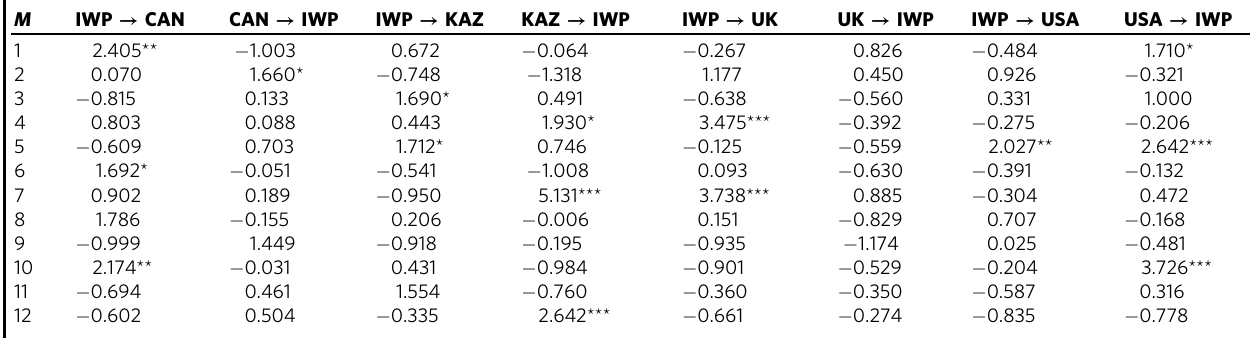
Table 6 Test statistics for causality-in-variance.